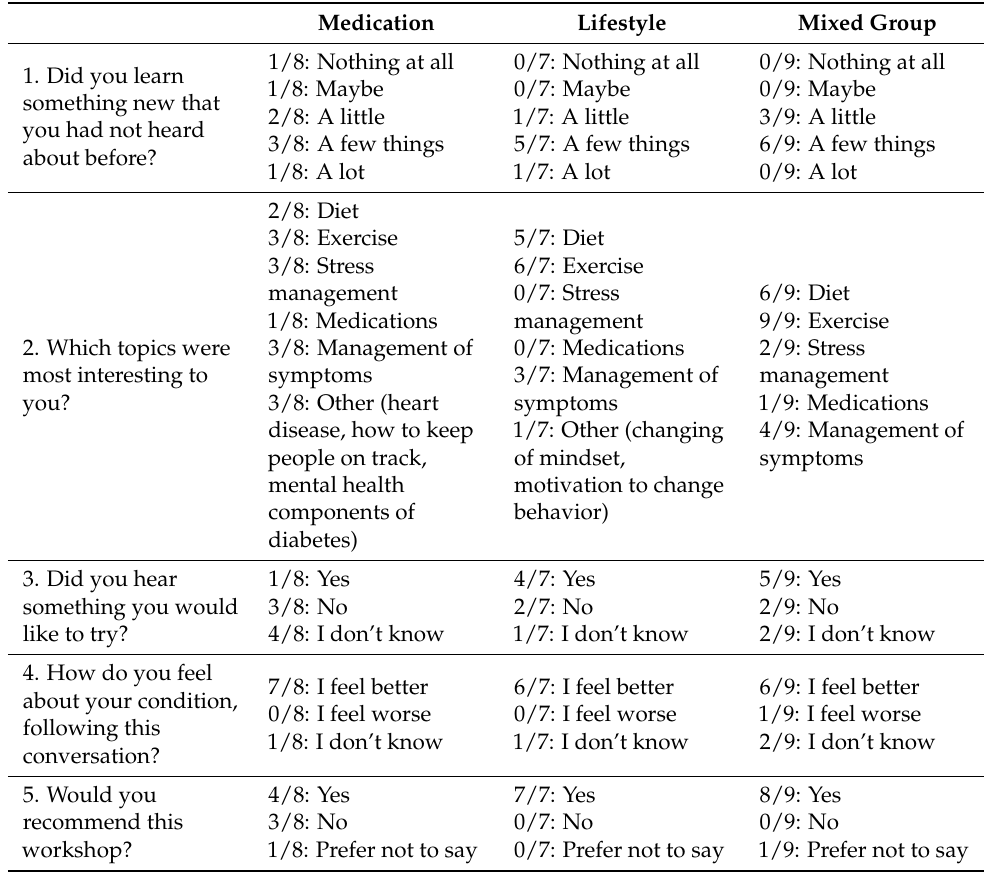
Table 2. Results of the workshop survey obtained from six workshops in the three patient groups. Medication Lifestyle Mixed